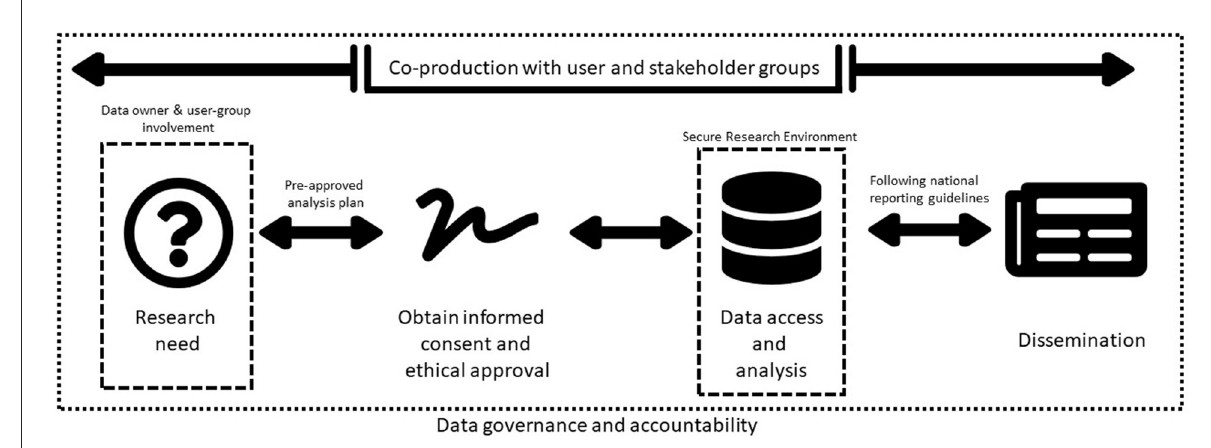
FIGURE1 Proposed framework to regulate and monitor researchers’ access to social media platform